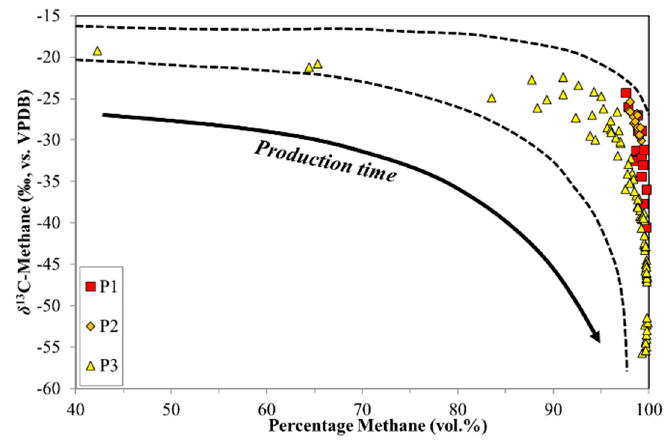
Figure 7. δ 13 C-CH 4 ratios from CBM production wells versus volume percentage of methane.